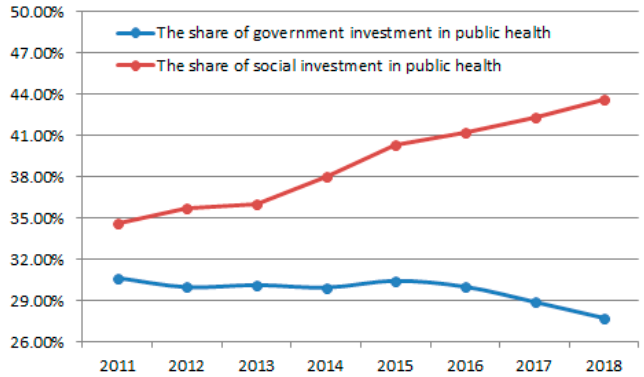
Figure 4. The share of government investment and social investment in public health from 2011 to 2018.